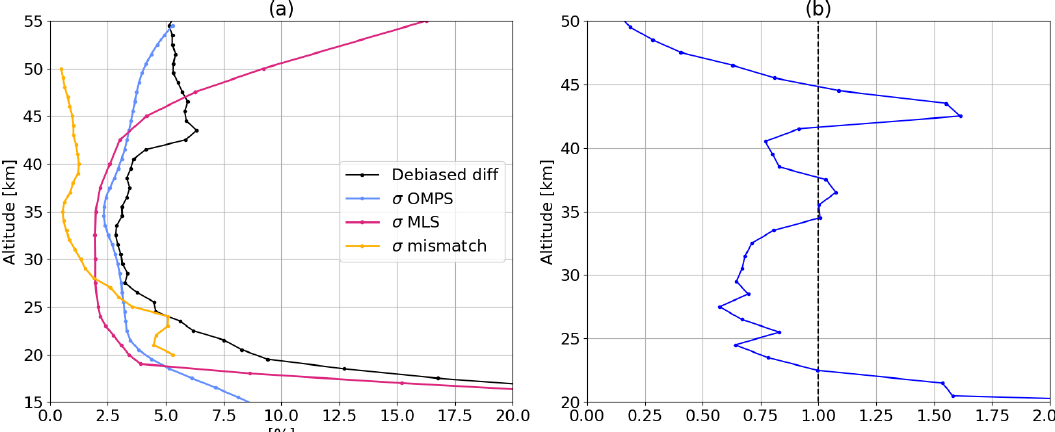
Figure 15. In panel (a) , contributing terms from Eq. (16) and de-biased rms difference between OMPS-LP and MLS (numerator of Eq. 15). In panel (b) , χ 2 values obtained as validation metrics for the combined OMPS-LP and MLS